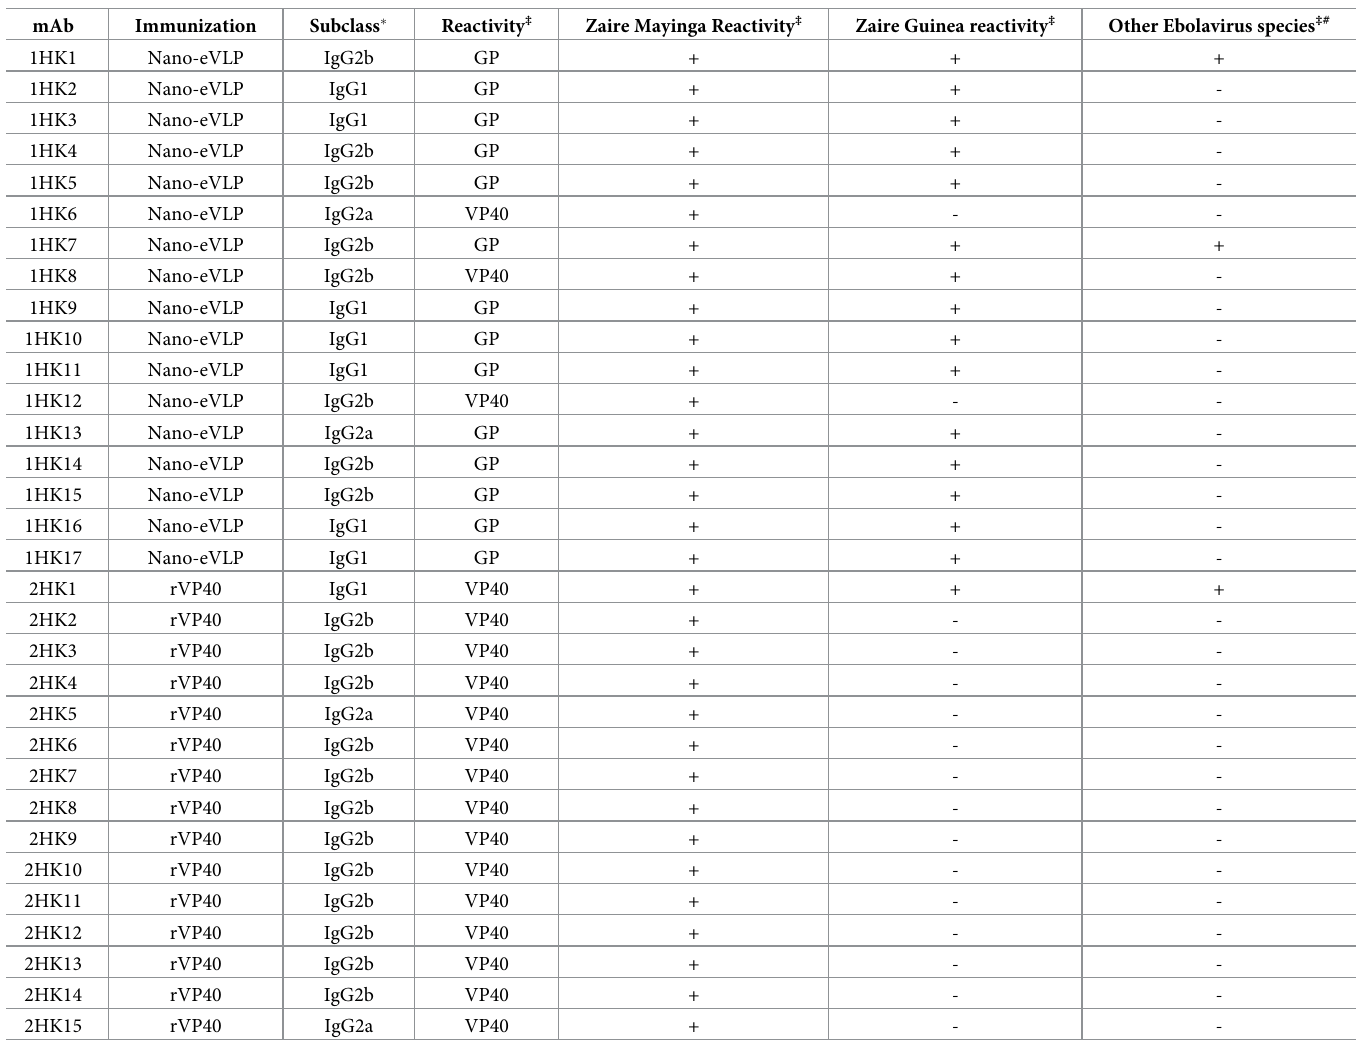
Table 1. Summary of GP and VP40 mAbs generated for this